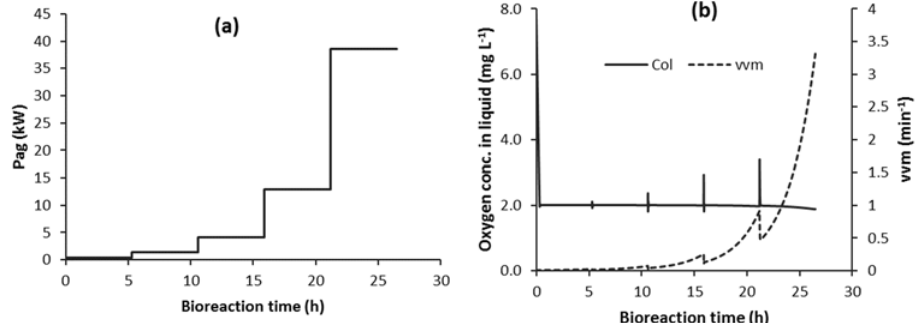
Figure 3. Scenario C1 ‐ 5: Effect of proportional, integral, and derivative (PID) control on ( a ) Pag step increases and ( b ) C OL and vvm (five equal time segments—non ‐ flooding).